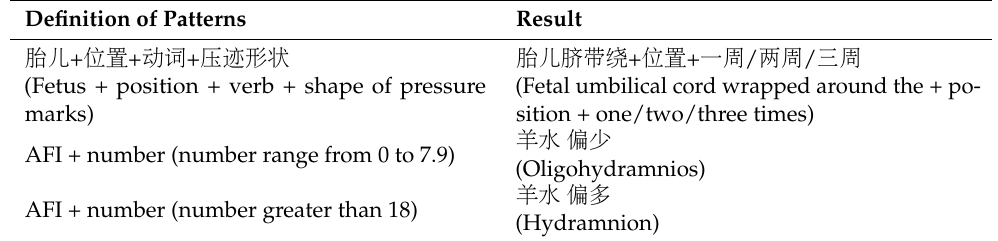
Table 5. Definition of